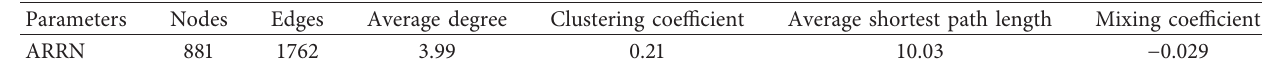
Figure 4: Air route reduced network model. Table 1: Basic topology features of the ARRN.